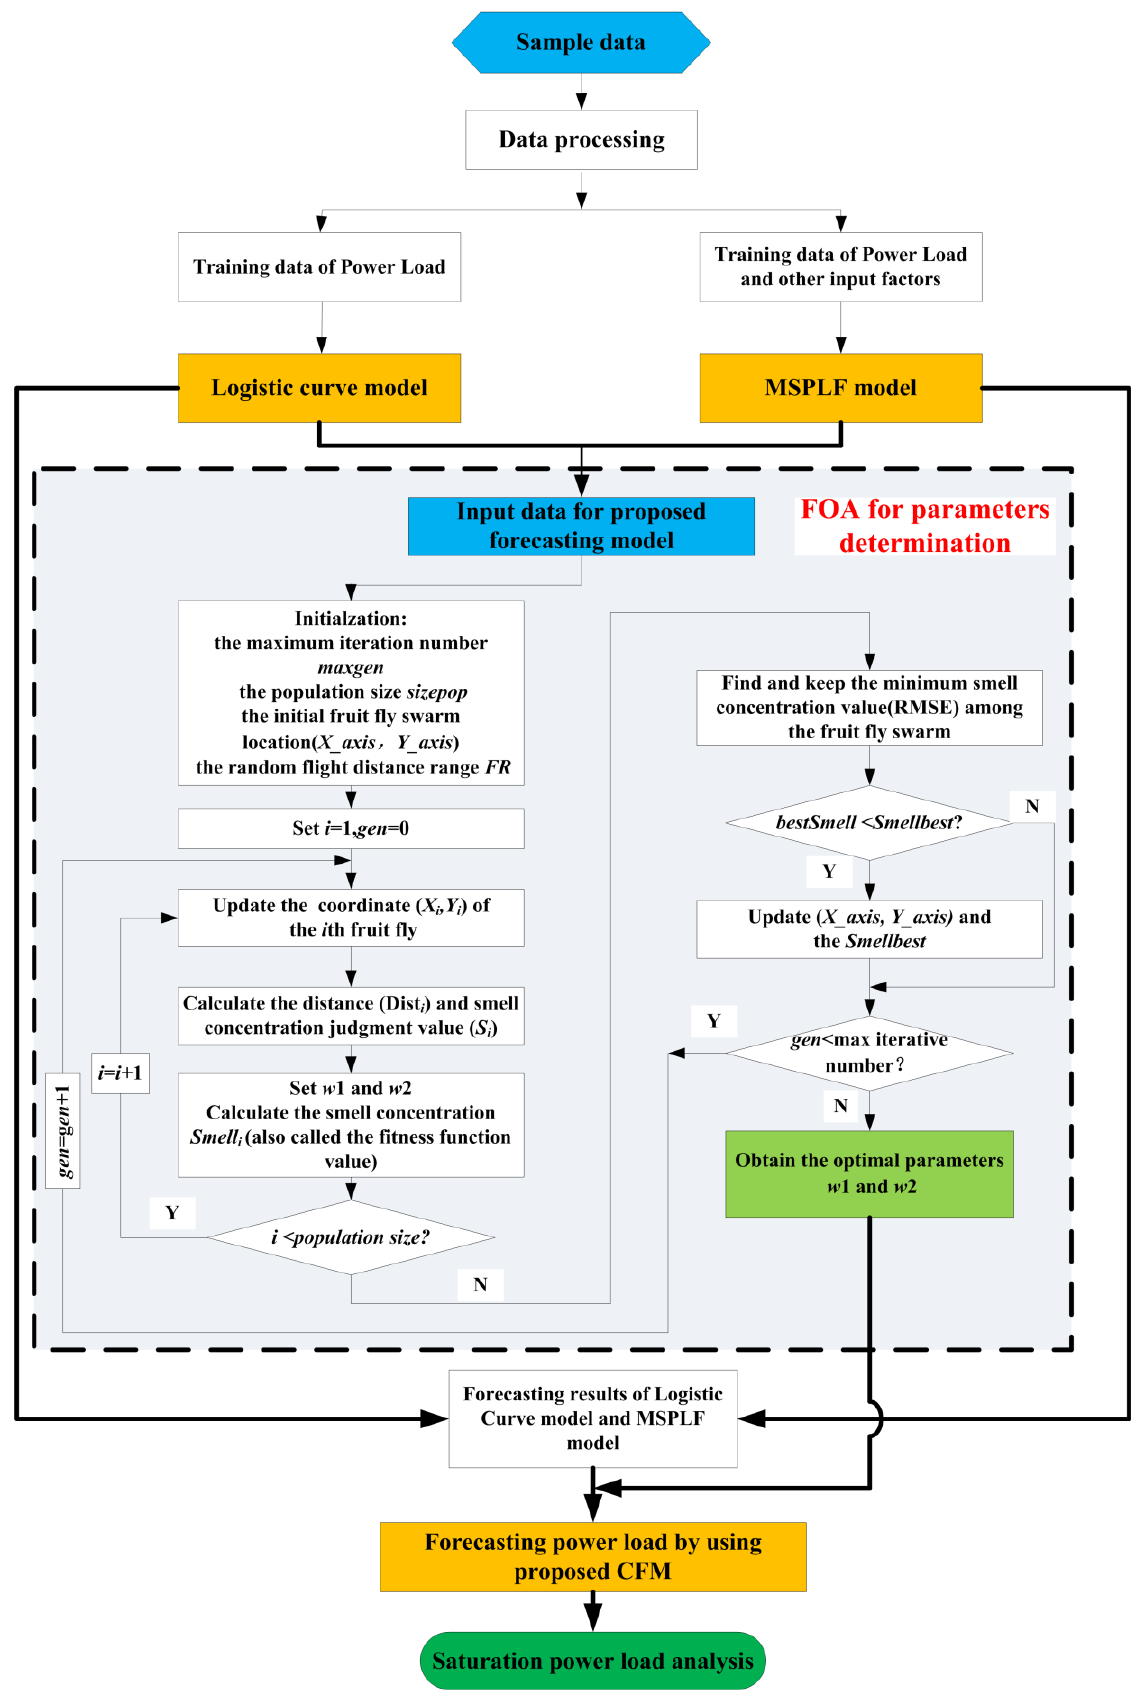
Figure 2. Flow chart of the proposed CFM for saturated power load